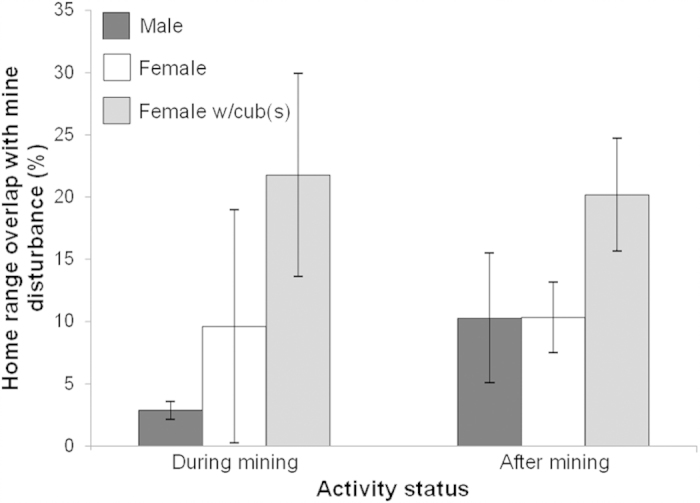
Mean annual home range overlap (95% fixed kernel) with Luscar and Gregg River combined mineral disturbance limits, Alberta, for grizzly bears monitored during (Nmales = 3, Nfemales = 3, Nfemales with cubs = 3) and after mining (Nmales = 2, Nfemales = 4, Nfemales with cubs = 3).Sample sizes include only individuals for which home ranges actually overlapped MDLs (overlap >0%). During mining data were collected in 1999–2003, whereas after mining data were collected in 2006 and 2008–2010. Error bars represent ± SD.